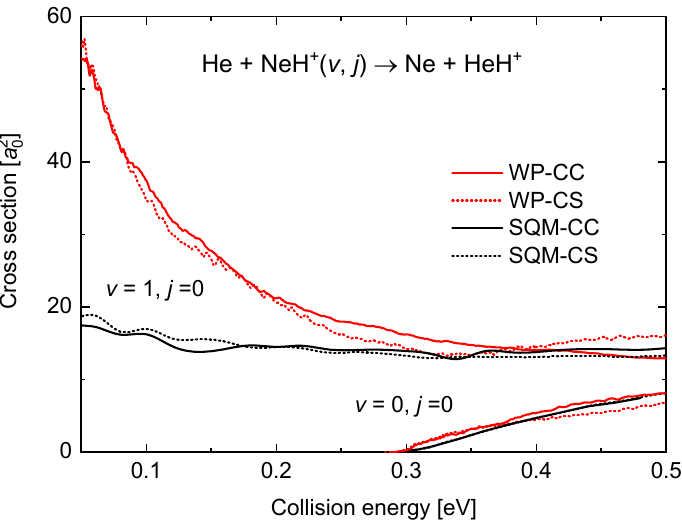
Figure 8. Integral cross sections (in bohr 2 ) as a function of the collision energy in eV for the He + NeH + ( v , j ) reaction. Results for ( v = 0, j = 0 ) (in the bottom right corner) are compared with those for ( v = 1, j = 0 ) . WP results (red lines) and SQM (black line) within the coupled-channel (solid line) and close-coupling schemes (dotted line) are from the work in